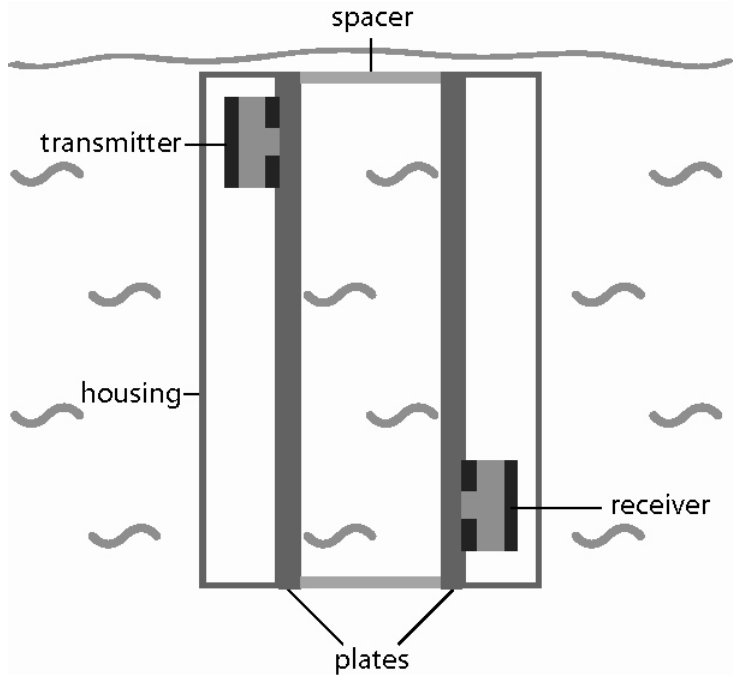
Figure 1. The acoustic wave guide sensor is dipped into the liquid in such a way that the investigated liquid is in the gap between the two plates.